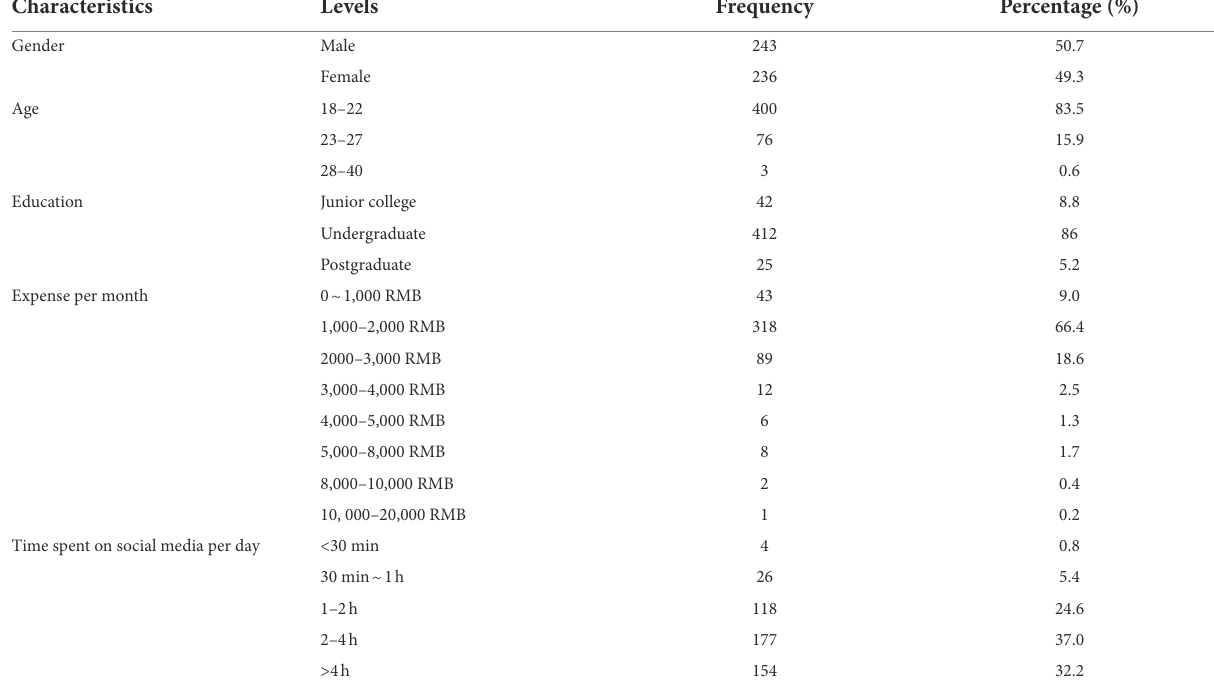
TABLE 1 Profile of the respondents.